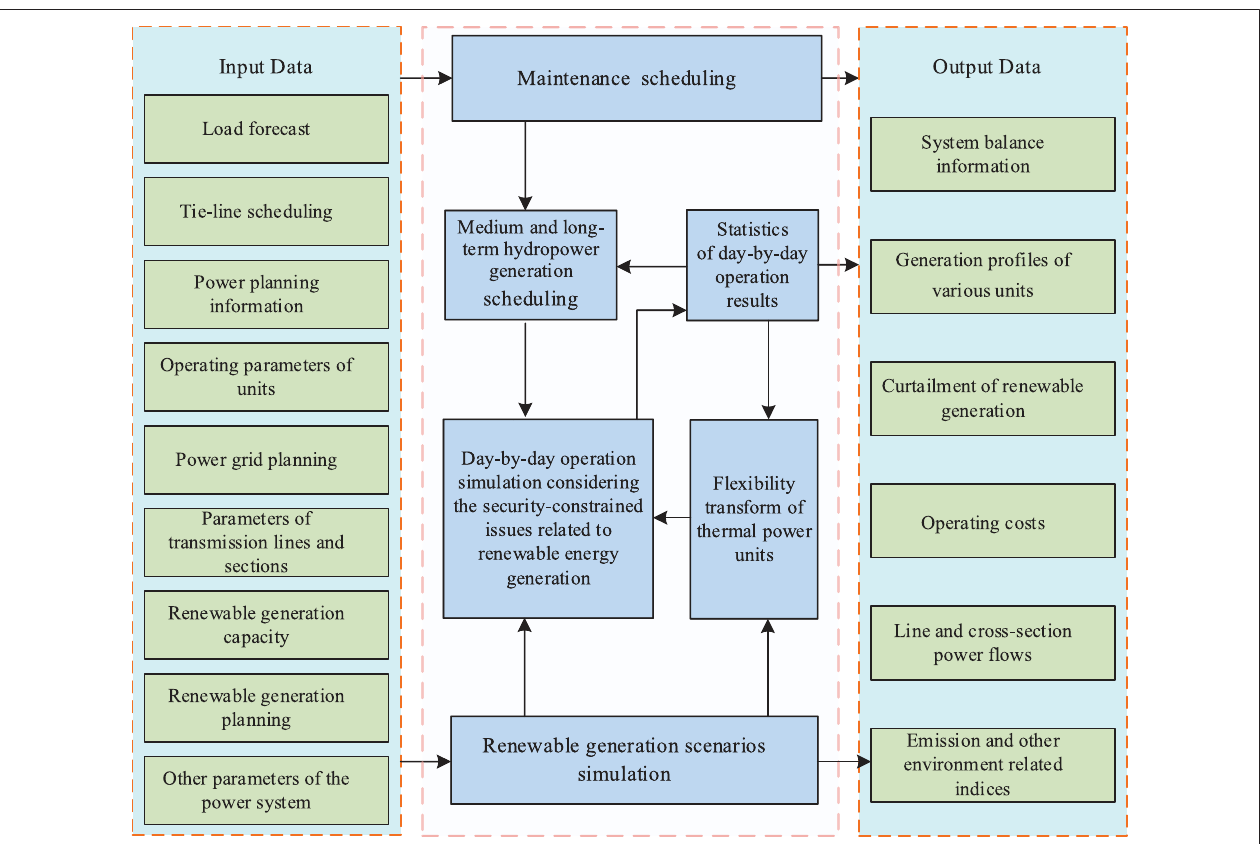
FIGURE 3 | Framework of power system operation simulation with fl exibility